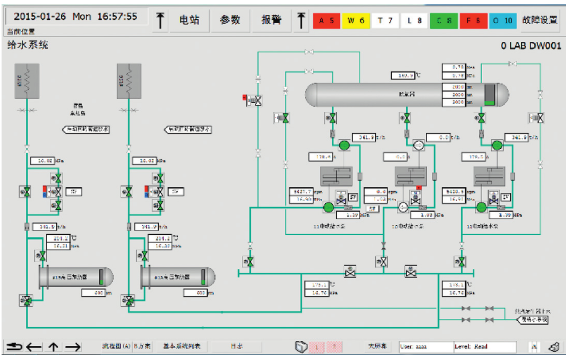
Figure 7: HMI for the feedwater system in vPower